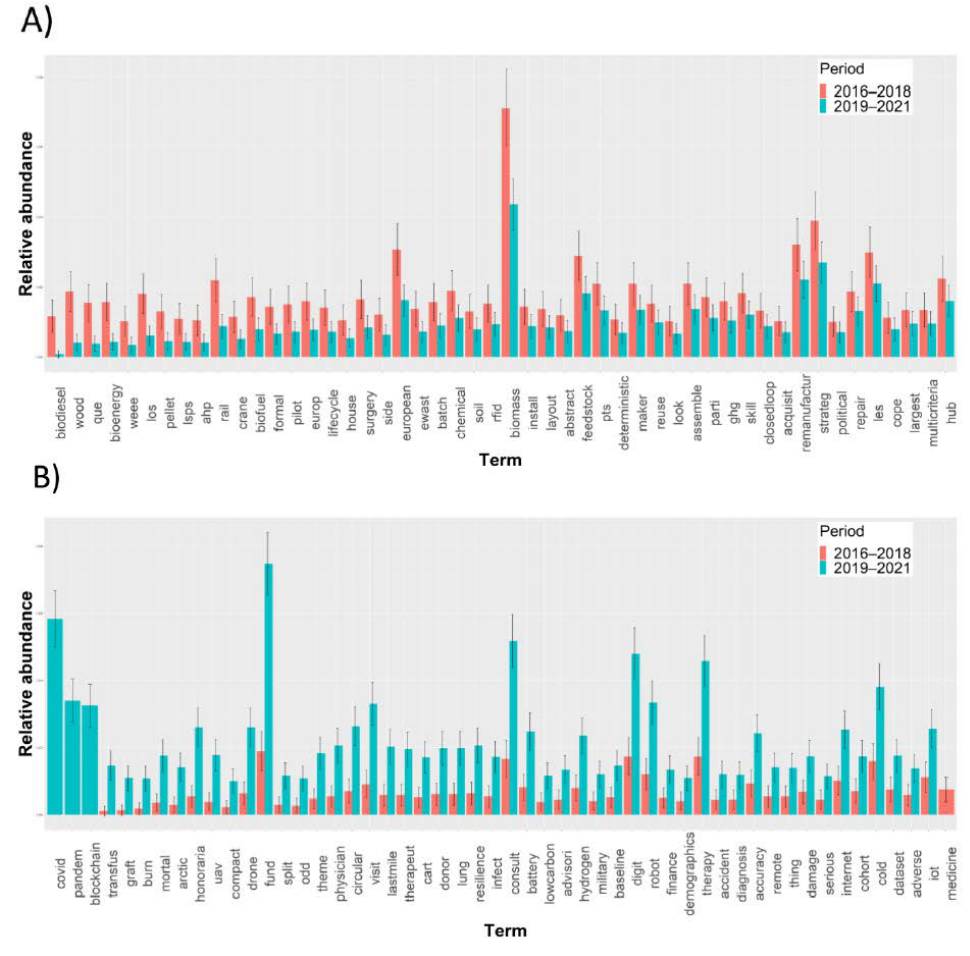
Figure 3. The relative word frequency of 50 words with the largest difference in relative abundance in the pre-COVID-19 ( A ) and 50 words with the largest difference in relative abundance during the COVID-19 period ( B ). The error bars show the 95% confidence